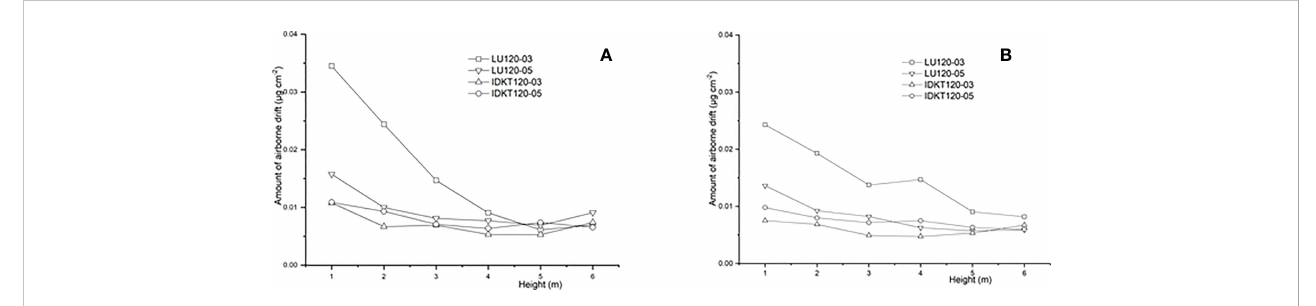
FIGURE 7 Airborne drifts of nozzles at 5 m (A) and 10 m (B) downwind